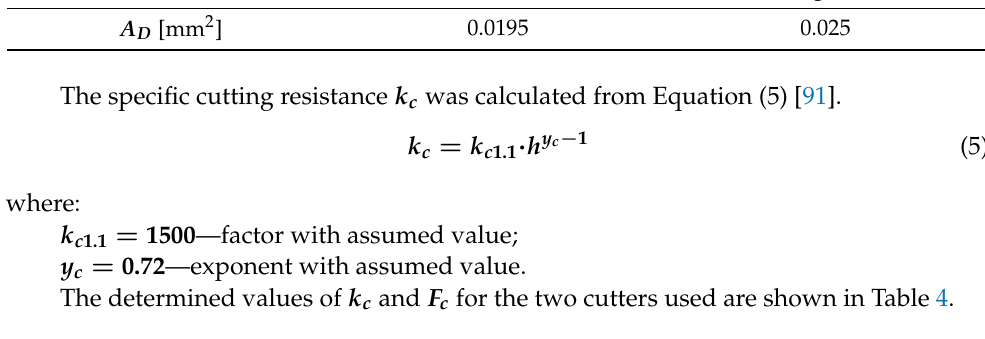
Table 3. Values of cutting are A D for the course and finishing milling cutter. Parameter Coarse Cutter ø4